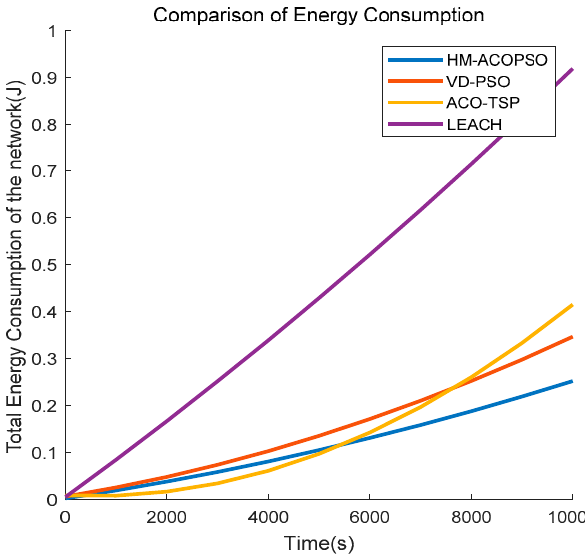
Sensors 2019 , 19 , x FOR PEER REVIEW Figure 9. Total energy consumption of the network. Figure 9. Total energy consumption of the network.